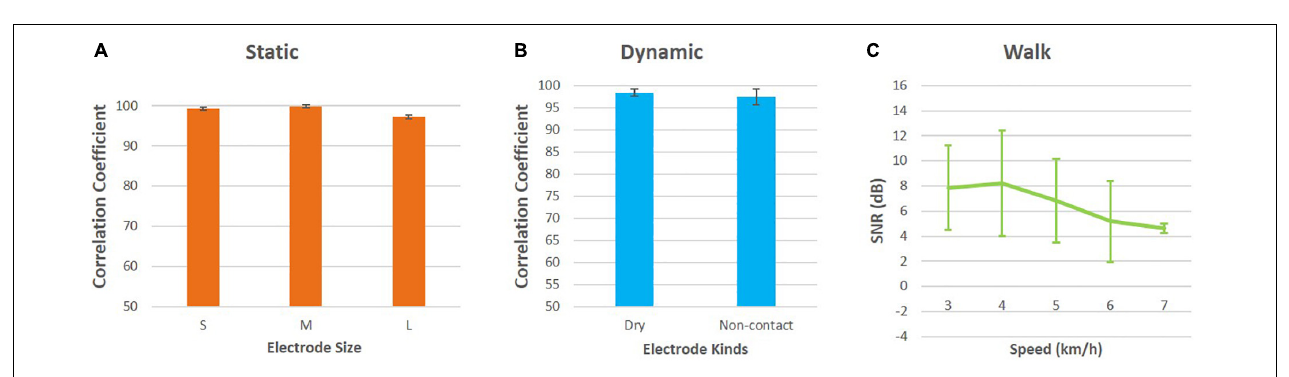
FIGURE 6 | Mathematical statistics analysis: (A) Correlation coefficients between electrodes of different sizes and wet electrodes under static conditions; (B) correlation coefficients between flexible non-contact electrodes, flexible dry electrodes and wet electrodes under motion; (C) SNR at different walking